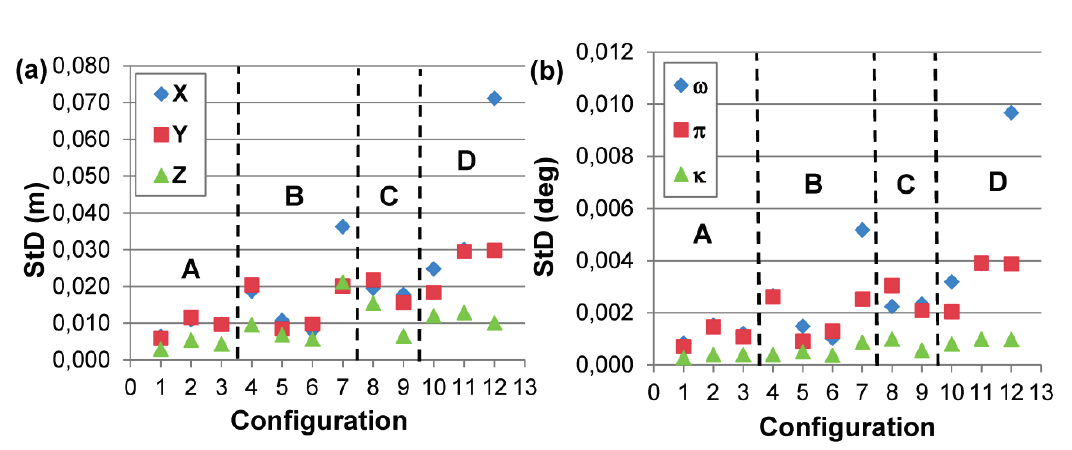
Figure 5. Sensitivity analysis on the influence of CGP distribution evaluated on the test field showing the standard deviation of the external orientation parameters: camera center coordinates ( a ) and attitude angles ( b ) On both figures the dashed lines separate the results relative to the four different classes: (A) well distributed GCPs; (B) poorly distributed GCPs; (C) few well distributed GCPs; (D) few badly placed